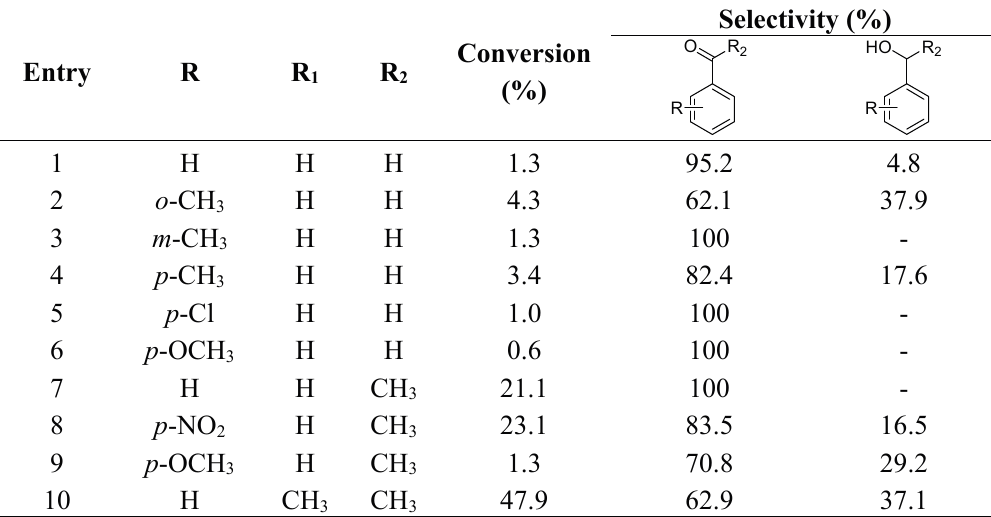
Table 2. Catalytic performance of Au NWs on the oxidation of